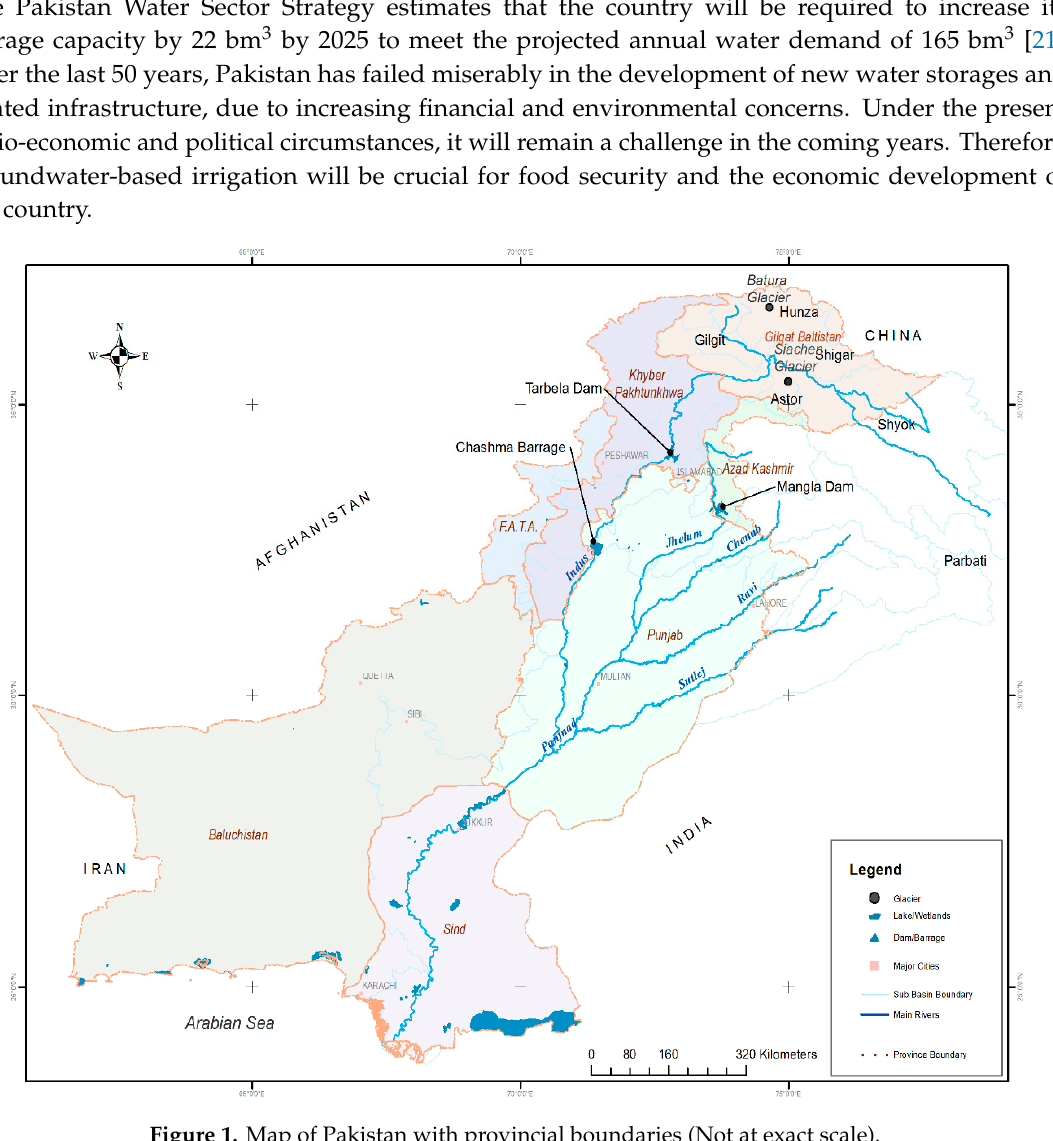
Figure 1. Map of Pakistan with provincial boundaries (Not at exact scale).